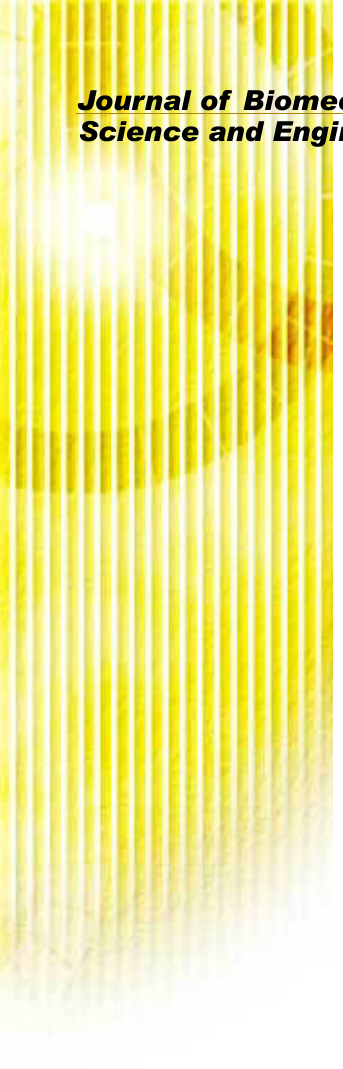
Fig. 2 The laser spot focused on the endothelial cell. (Arrow heads) (a) The laser spot was focused on the nucleus of EC. (b) The laser spot was moved out of the